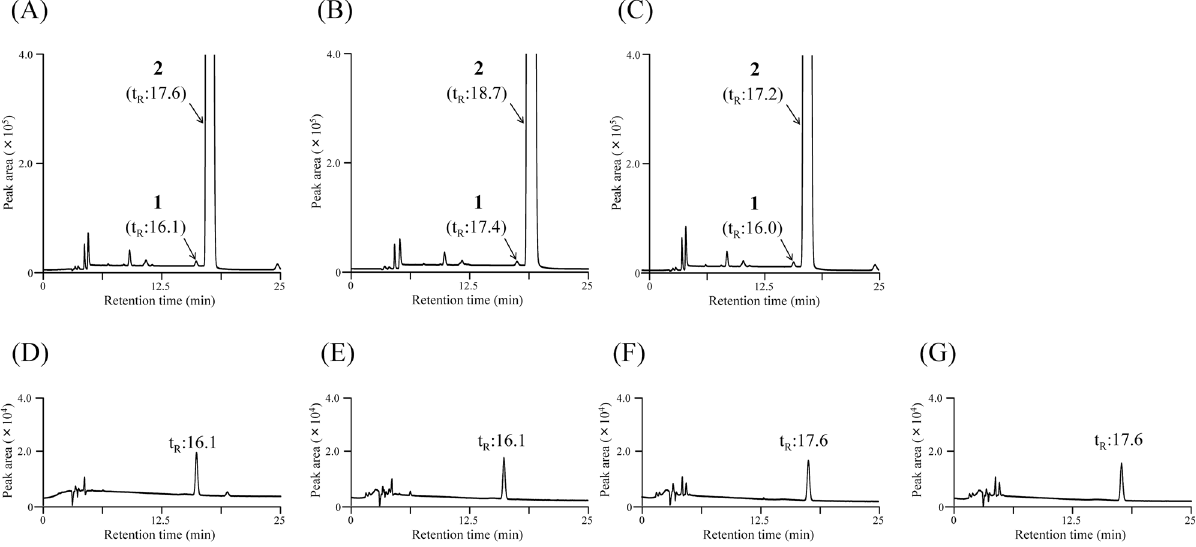
Fig 2. Representative HPLC chromatograms of an L, L-APM standard solution spiked with L, D-APM of 0.04 wt% (A, B, and C), L, D-APM (D), D, L-APM (E), L, L-APM (F), and D, D-APM (G) (all standard solutions; 0.2 μ g/mL). Chromatograms A, D, E, F, and G were obtained using the L-column2 ODS column (column 1). Chromatograms B and C were obtained using the TSK-gel ODS 80 Ts column (column 2) and Mightysil RP-18 GP column (column 3), respectively. The peaks labeled 1 and 2 in chromatograms A — C correspond to L, D-APM and L, L-APM, respectively.